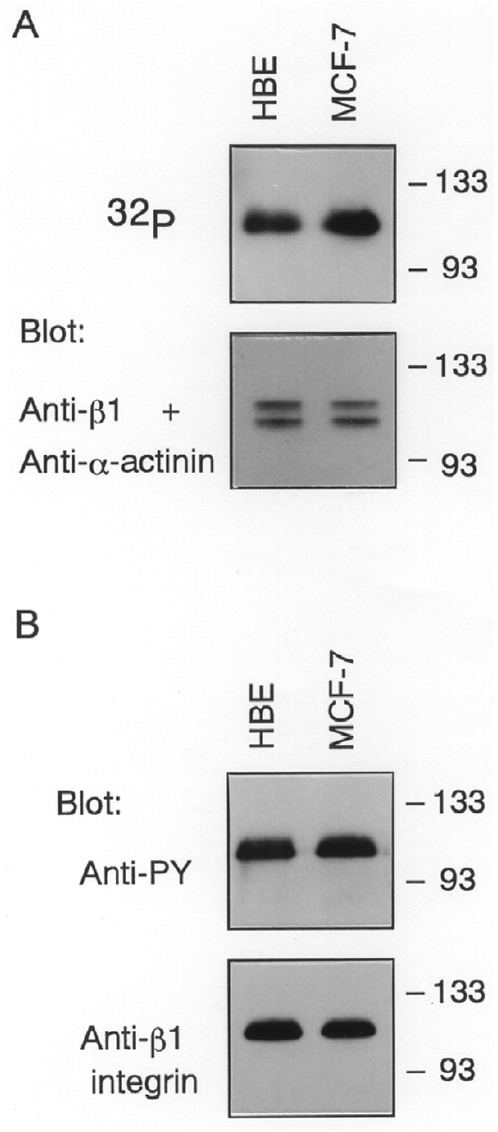
Figure 4 The phosphorylation state of β 1 integrin. (A) HBE or MCF-7 cells which were quiescent and adherent to collagen IV were metabolically labeled with [ 32 P]orthophosphoric acid and β 1 integrin was immunoprecipitated from the cells. After separation on 8% SDS-PAGE, gels were dried and autoradio- graphed. Unlabeled samples were electrophoresed and trans- ferred onto membranes. The blots were probed with antibodies to β 1 integrin and α -actinin. Molecular size mark- ers are indicated at right in kDa. (B) Tyrosine phosphoryla- tion of β 1 integrin in HBE and MCF-7 cells. Integrin β 1 was immunoprecipitated from HBE or MCF-7 cells and the immu- noprecipitates were resolved by 8% SDS-PAGE before blot- ting. The blots were then probed with anti-PY or anti- integrin β 1 monoclonal antibody. Molecular size markers are indicated at right in kDa.